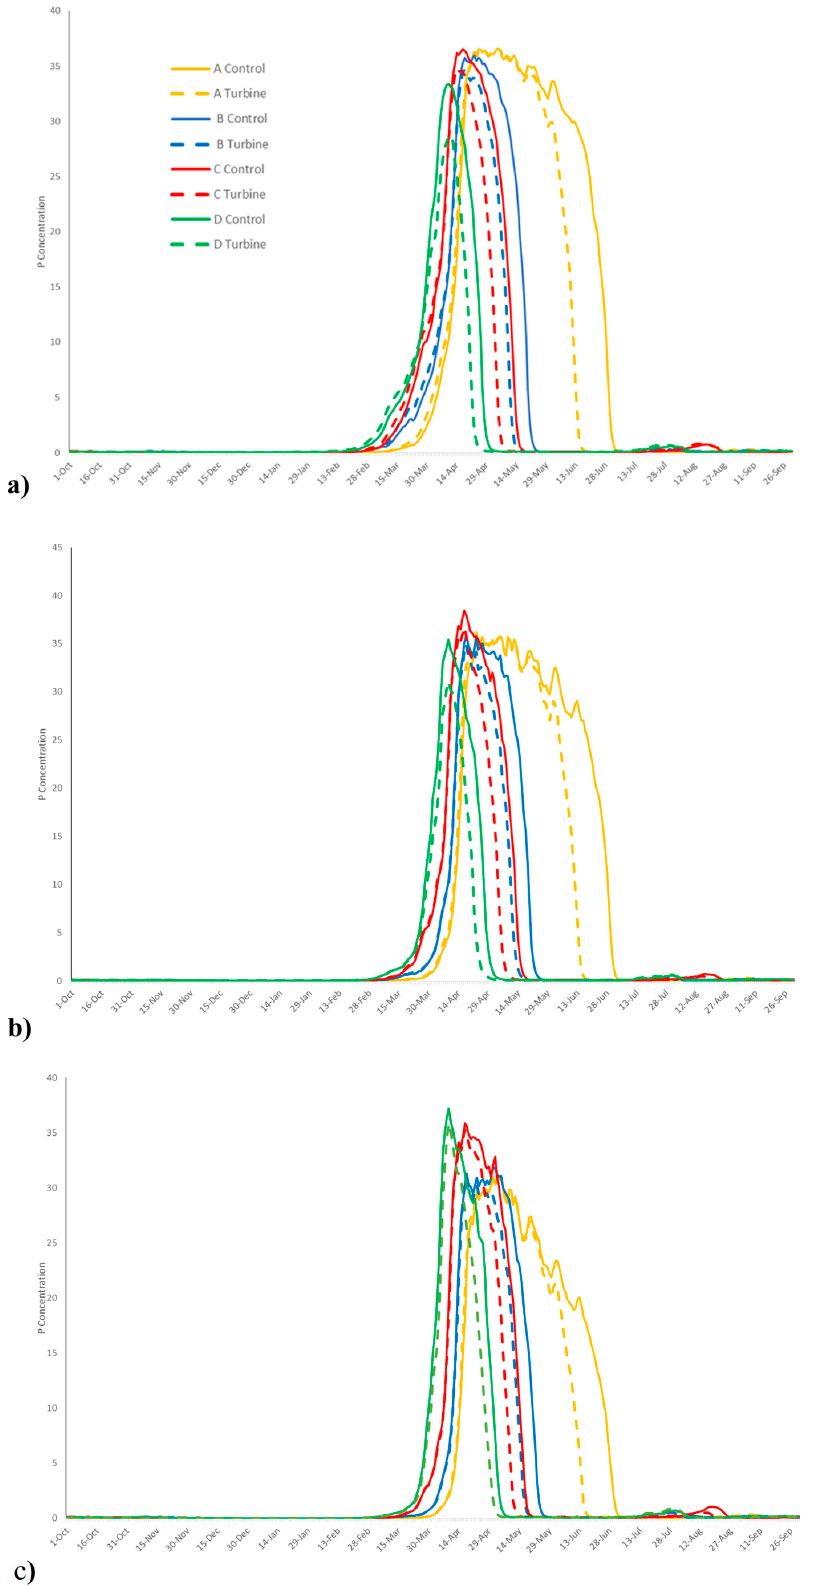
Figure 6. Time-series of daily phytoplankton concentrations as average for the three different areas (Figure 1), the basin ( a ); channel ( b ); and open sea ( c ) for all four PAR scenarios A–D (Figure 4) and scenarios with and without an array of TEDs.